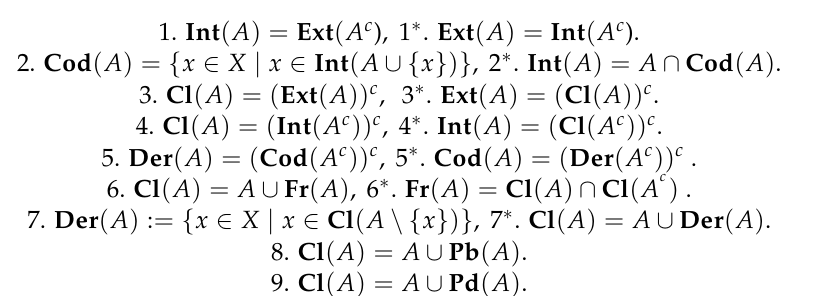
Figure 1. Relations Between